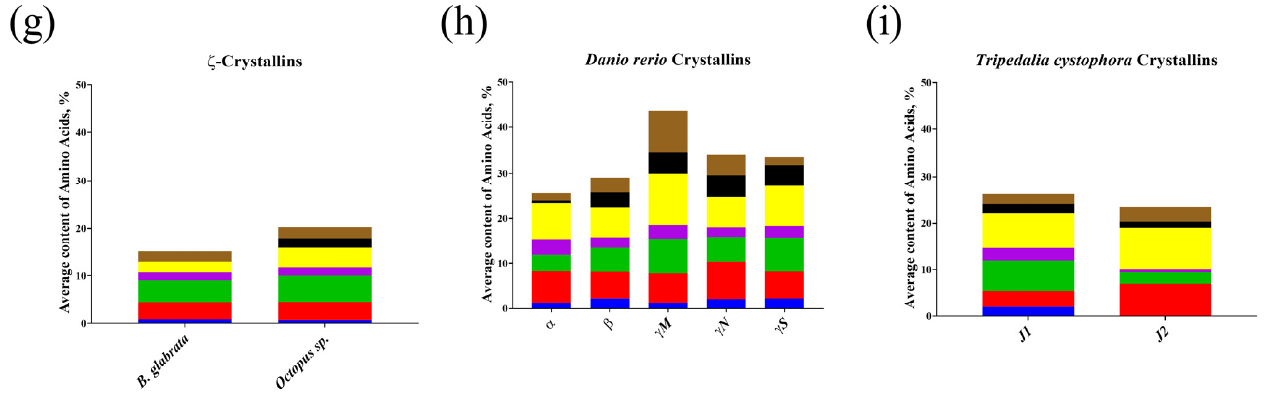
Figure 1. Average percentage contents of the most highly polarized amino acids in the sequences of mollusc crystallins and lens crystallins of Danio rerio and Tripedalia cystophora . A different situation was observed in the amino acid composition of J1A-crystallins of molluscs (Figure 1b). The proportion of all analyzed amino acids in them was 18%, which was markedly less compared not only with α -crystallins of molluscs, but also with